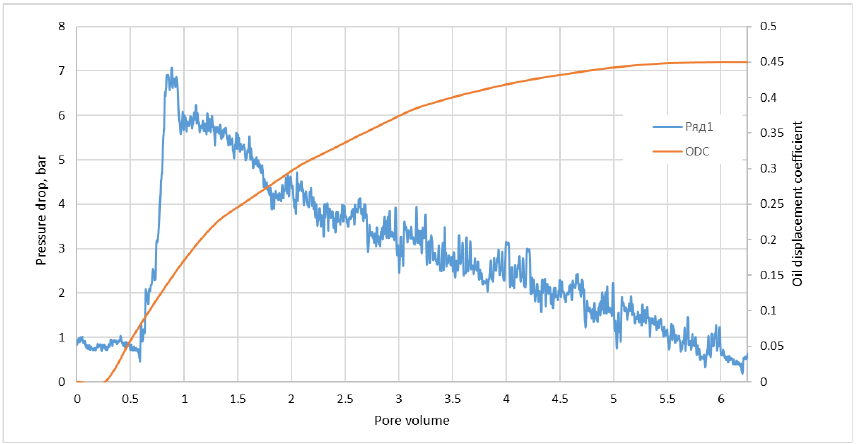
Figure 3. Pressure drop and oil displacement coefficient in experiment № 3.